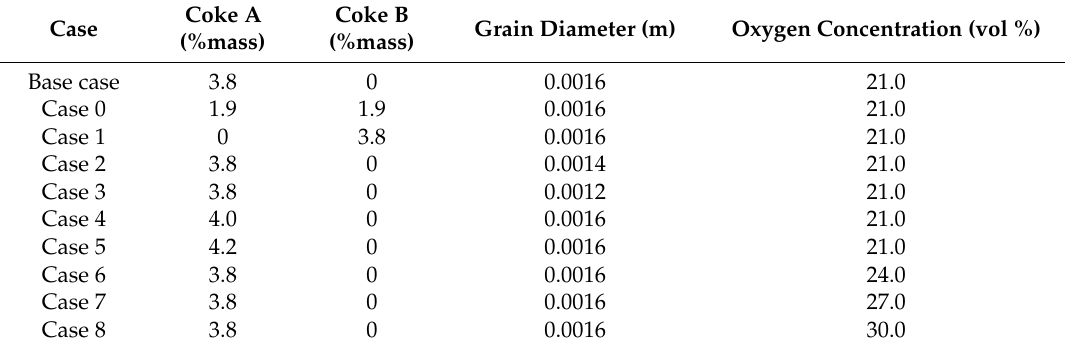
Table 4. Operational parameters for simulated